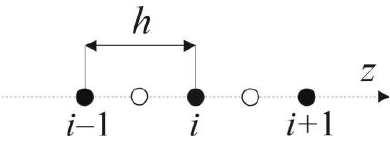
Figure 3. Three-points star.